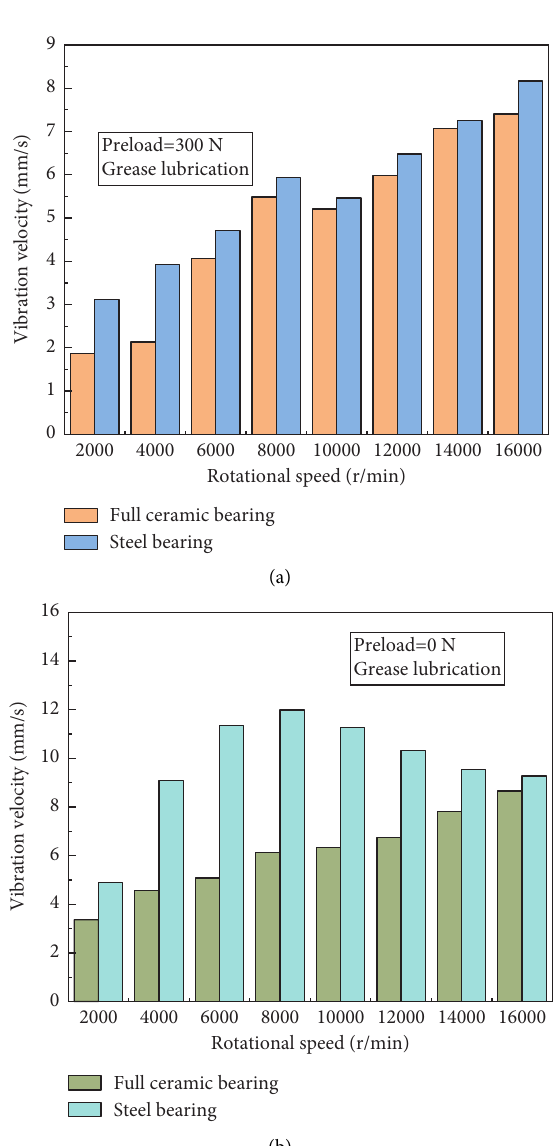
Figure 12: Vibration velocity comparison of Si 3 N 4 full-ceramic bearings and steel bearings under grease lubrication condition. (a) Condition of applying preload. (b) Condition of no preload.